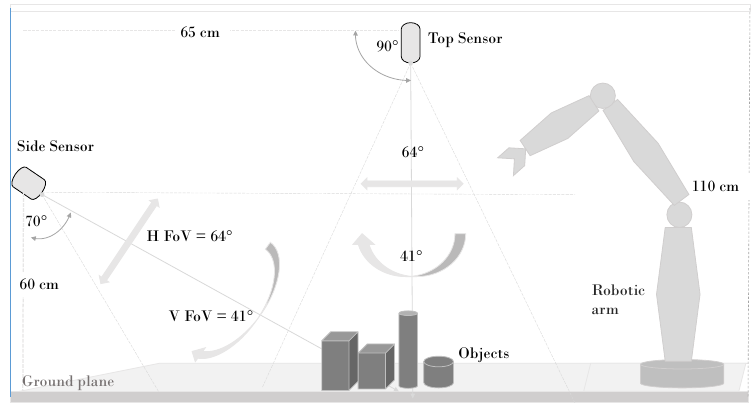
Figure 7. Experimental setup. Top sensor provides an initial estimate of the ROI and the images from the side view camera provide a final object detection and